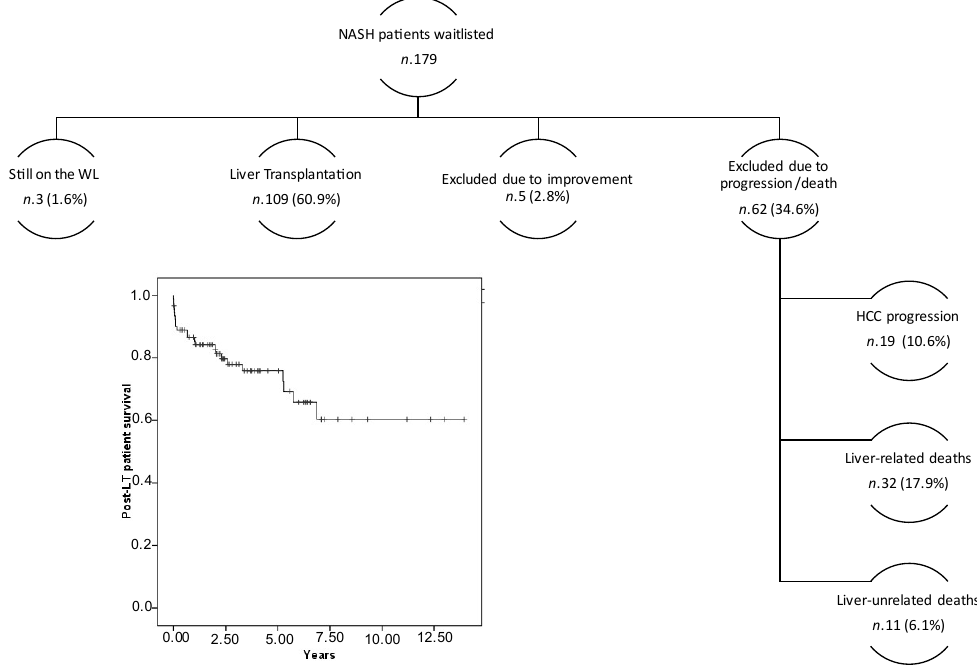
Figure 3. Outcomes of the waitlisted patients with NASH, and post-transplant survival in those who underwent liver transplantation.